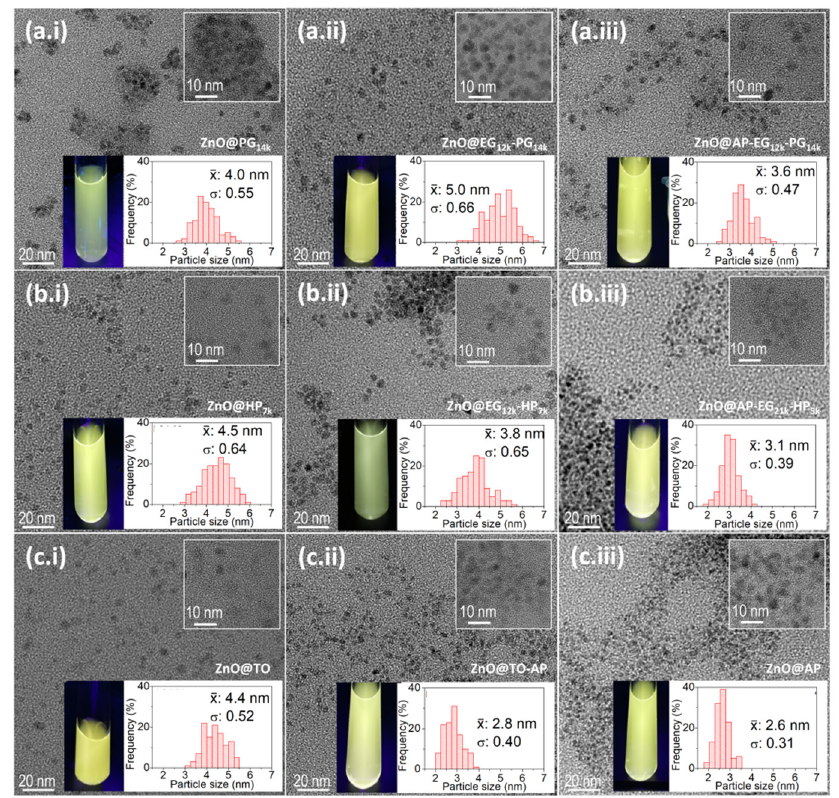
Figure 4. Representative TEM images of ZnO QDs with different coatings: ( a.i ) ZnO@PG 14k ; ( a.ii ) ZnO@EG 12k -PG 14k ; ( a.iii ) ZnO@AP-EG 12k -PG 14k ; ( b.i ) ZnO@HP 7k ; ( b.ii ) ZnO@EG 12k -HP 7k ; ( b.iii ) ZnO@AP-EG 21k -HP 5k ; ( c.i ) ZnO@TO; ( c.ii ) ZnO@TO-AP; and ( c.iii ) ZnO@AP. Inserts show photos under UV light (365 nm) and particle size histograms corresponding to the samples indicated in the